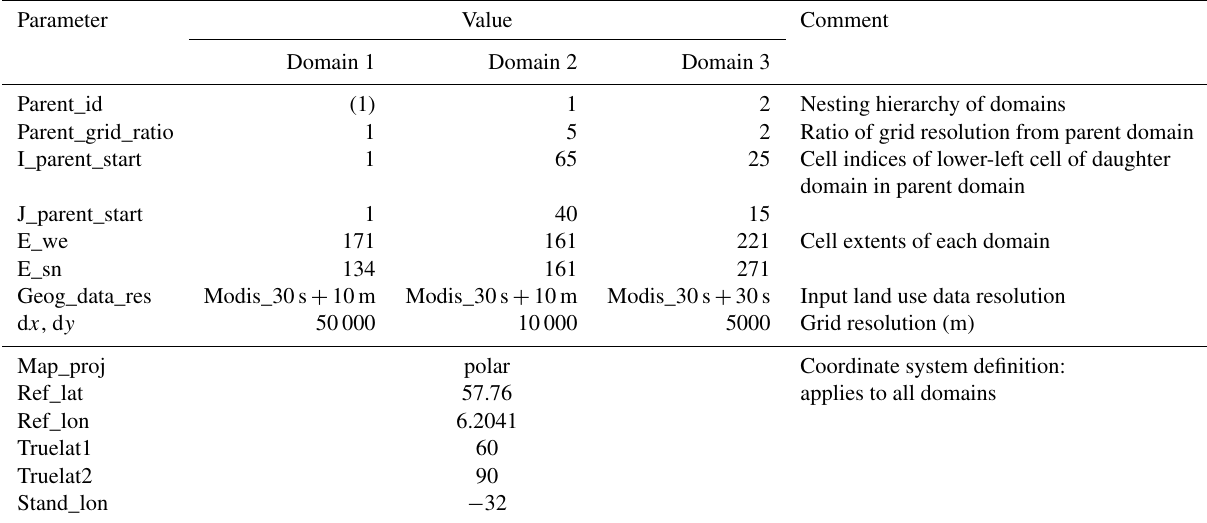
Table A1. Definitions of WRF modelling domains used for the EMEP4UK modelling system. Note that domain 2 is only used for meteoro- logical